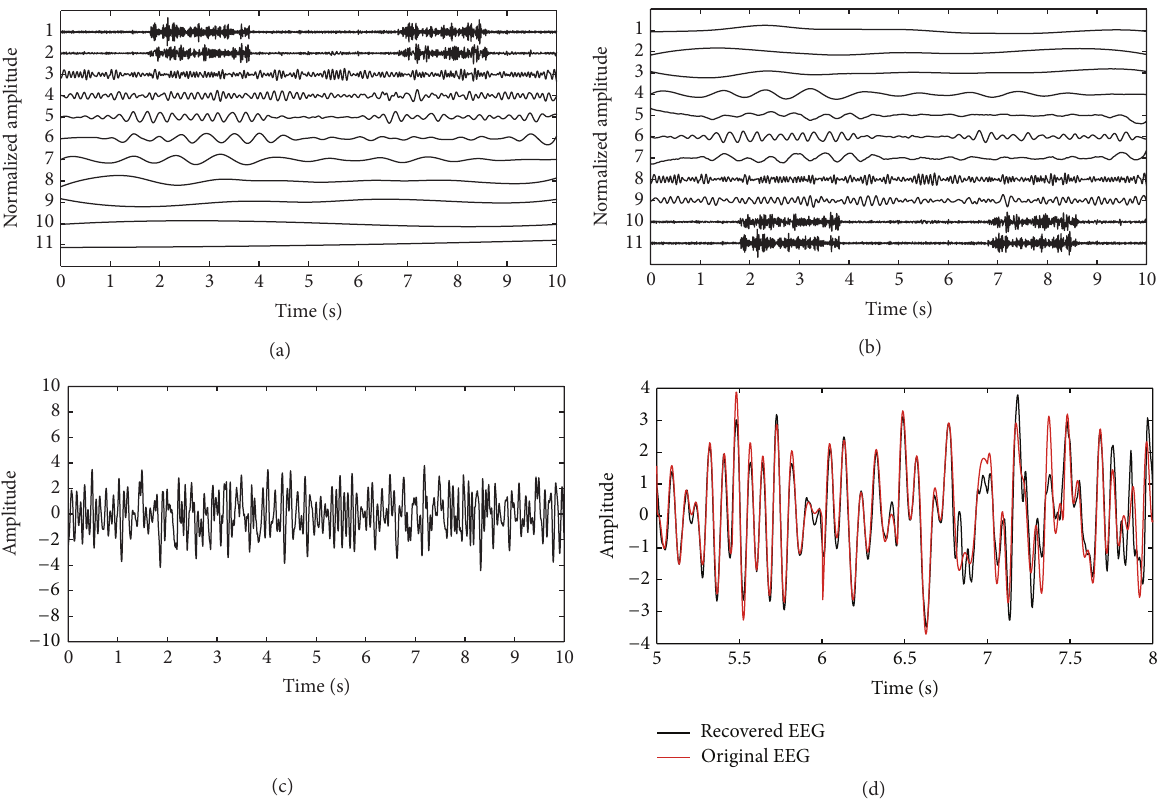
Figure 5: The stepwise results of the proposed method: (a) the IMF components after applying EEMD to the single-channel EEG x ( 𝜀 = 1.5 ); (b) the canonical variates after using MCCA ( 𝑀 = 3 ); (c) the reconstructed EEG signal ̂ x after muscle artifact removal; (d) the amplified version of ̂ x compared with the original EEG x EEG